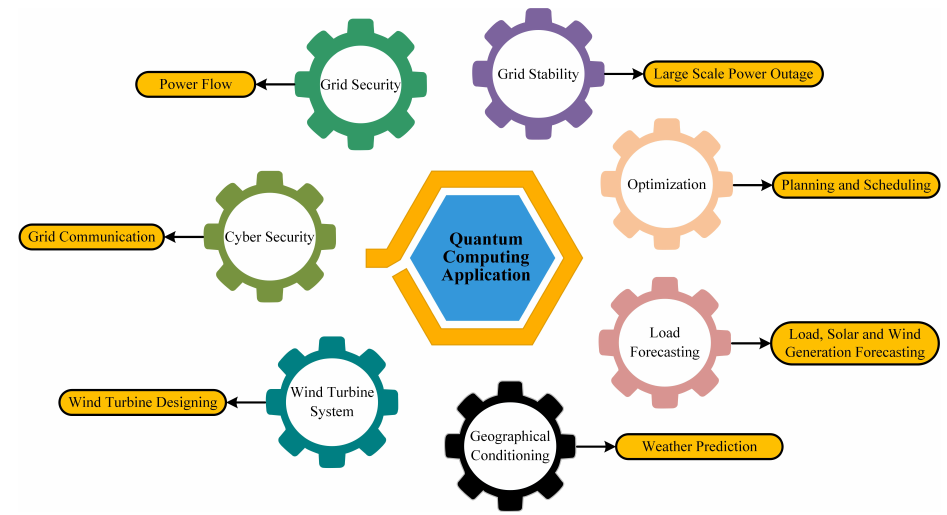
Figure 8. Application of quantum computing